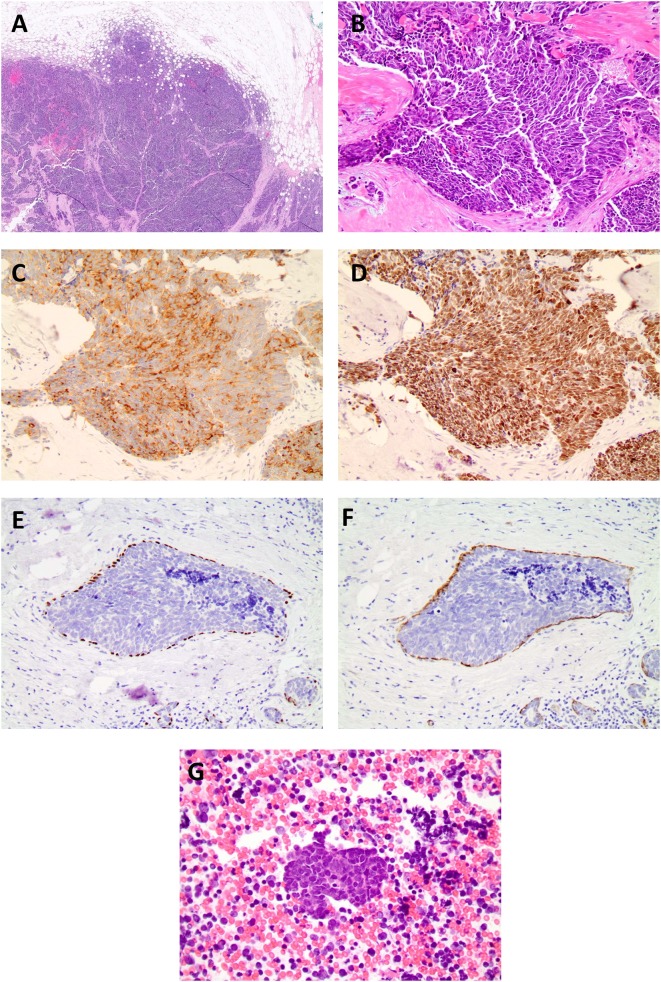
(A) Histopathological examination of the specimen stained on low (4x), (B) high power field (20x, 40x) showed neoplastic cells with high nuclear: cytoplasmic ratio, hyperchromatic nuclei, minimal cytoplasm, and indistinct nuclei, nuclear molding, high mitotic rate, consistent with the diagnosis of small cell carcinoma. Biopsy of breast cancer primary. Immuno-histochemical staining for TTF-1 synpatophysin, chromogranin, and p40 and smooth muscle myosin staining (SMMS) consistent with a diagnosis of primary SCCB, (C) small cell synaptophysin 20X. (D) small cell TTF-1 20X. (E)
In situ component with neuroendocrine differentiation p40. (F)
in situ component smooth muscle myosin stain. (G) Histopathological examination of the fine needle aspiration of the sub-carinal node revealed metastatic small cell carcinoma (Lymph node 40x).